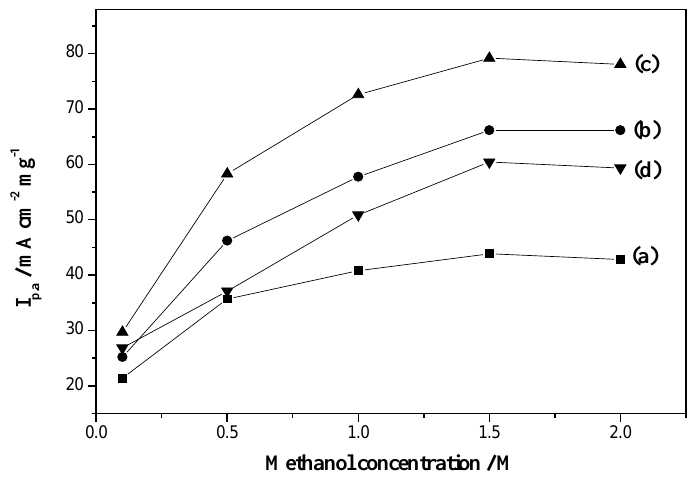
Figure 10. Plot of anodic peak current as a methanol concentration for ( a )